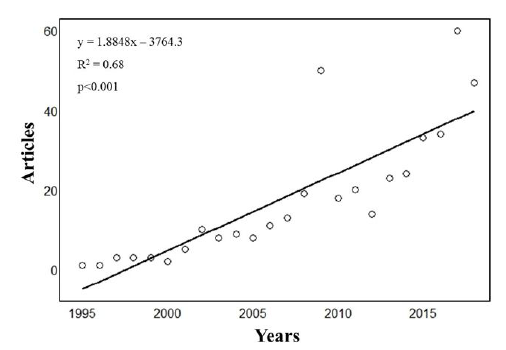
Figure 2. Simple linear regression analysis of the number of articles published from 1995 to 2018 found on the Web of Science (ISI) database.